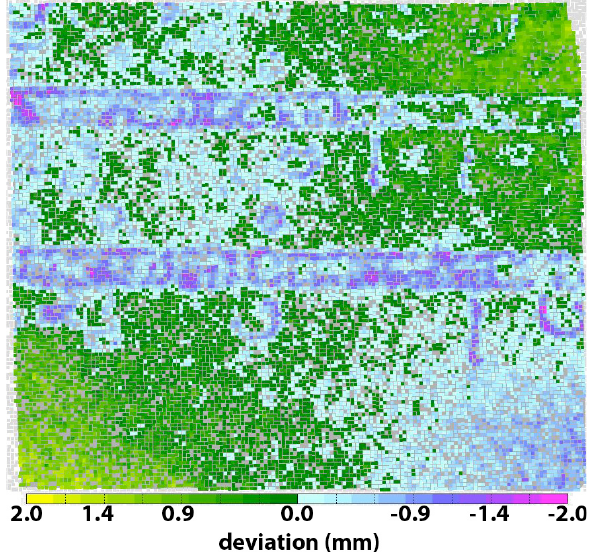
Figure 1. High-resolution point cloud obtained from a Hindu inscription carved on the foundation stone